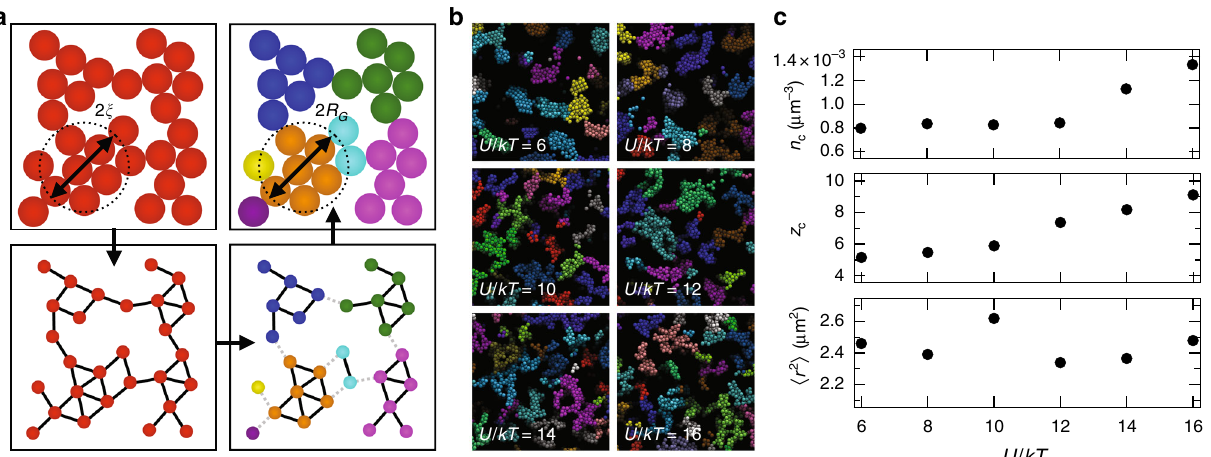
Fig. 2 Graph decomposition of depletion gels formed by arrested phase separation. a Illustration of the l -balanced graph partition algorithm applied to a model gel. In counter-clock-wise order: the network is converted into a graph with particles representing vertices and bonds representing edges, the graph is partitioned into subgraphs containing no more than l vertices ( l = 6 here), and the subgraphs are used to color the depletion gel. b Snapshots from simulation data at varying U / kT of depletion gels after coloring with the graph partitioning scheme. The subgraph size l is chosen so that the correlation length ξ equals the average radius of gyration of the clusters found via partitioning. c The subgraph number density, the average number of contacts between subgraphs, and the averaged square subgraph contact length: 〈 r 2